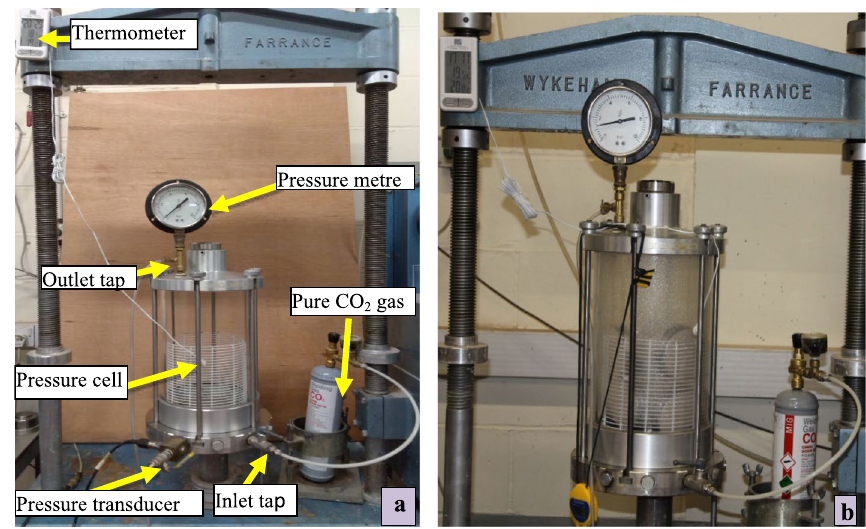
Fig. 1 Reaction apparatus for sample carbonation a , empty setup b , stacked with oedometric